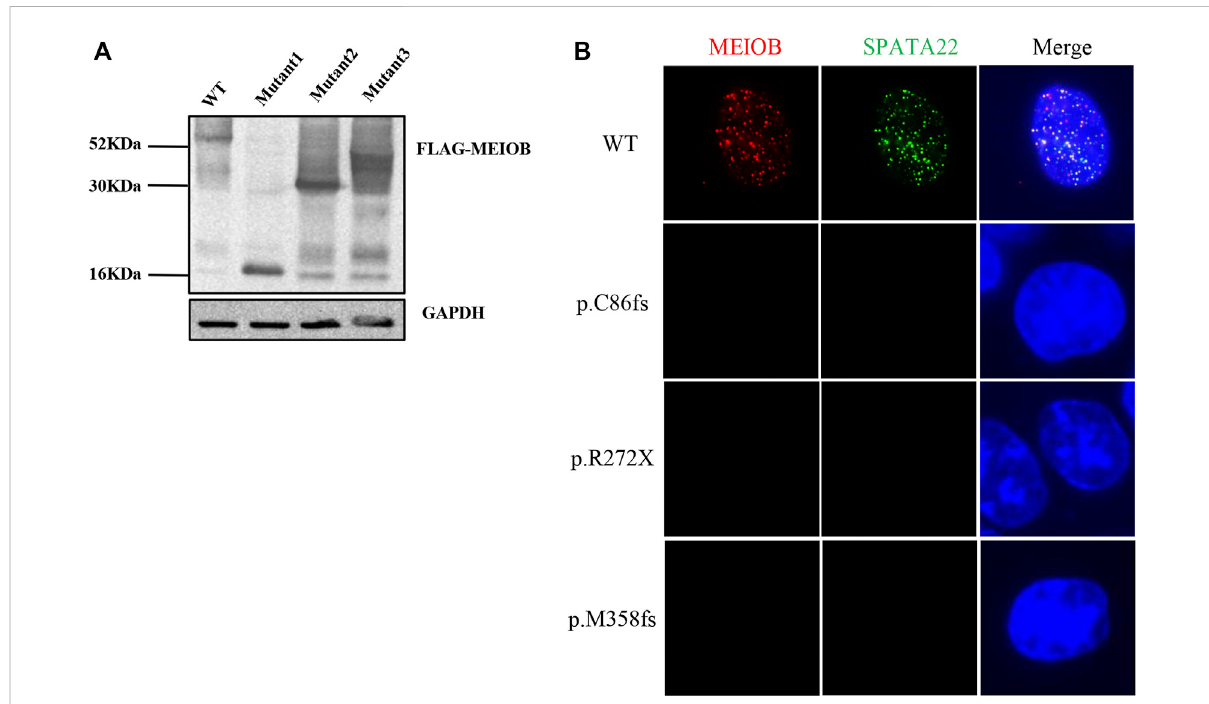
FIGURE 2 Invitro functionalanalysisofMEIOBvariant. (A) Westernblotanalysisshowedthatthethreemutantproteinswereexpressedintransfectedcells, which resulted in the production of truncated proteins. (B) Immuno fl uorescence analysis showed that the wild-type MEIOB colocalised with SPATA22 to ssDNA; the truncated MEIOB was not located in the